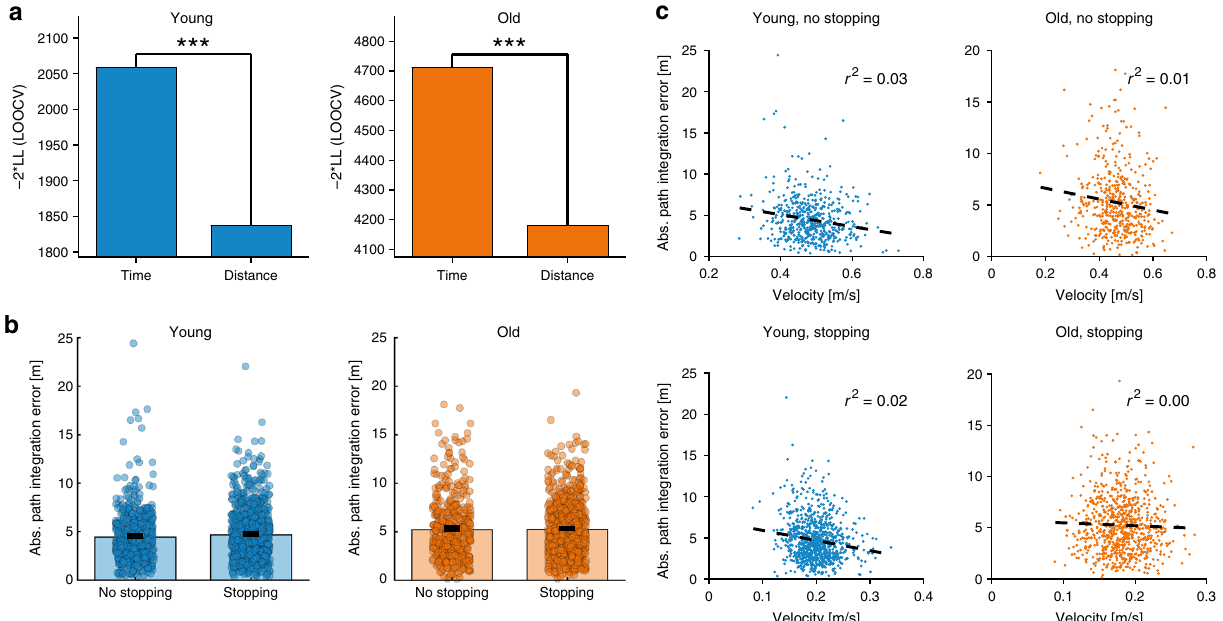
Fig. 4 Time-scaling versus distance-scaling of accumulating noise. a Model comparison using LOOCV between the full model with accumulated error proportional to total travel distance versus total time in trajectory. For both age groups, the full model is better supported by the data. Higher bars indicate poorer model- fi t. *** Denotes “ very strong ” evidence against the model with poorer fi t ( Δ BIC or Δ LOOCV ≫ 10; see “ Methods ” section on model comparison, and Supplementary Fig. 7). b Average path integration error at the last stopping point, in trials with and without intermediate stopping points. The path integration error is very similar even though trials with stopping take much more time, indicating that the path integration error mainly scales with distance rather than time. Error bars indicate mean ± SEM (young adults: n = 540 trials without stopping vs. 900 trials with stopping; older adults: n = 468 trials without stopping vs. 780 trials with stopping). c Walking velocity versus path integration error for trials with and without stopping and for both age